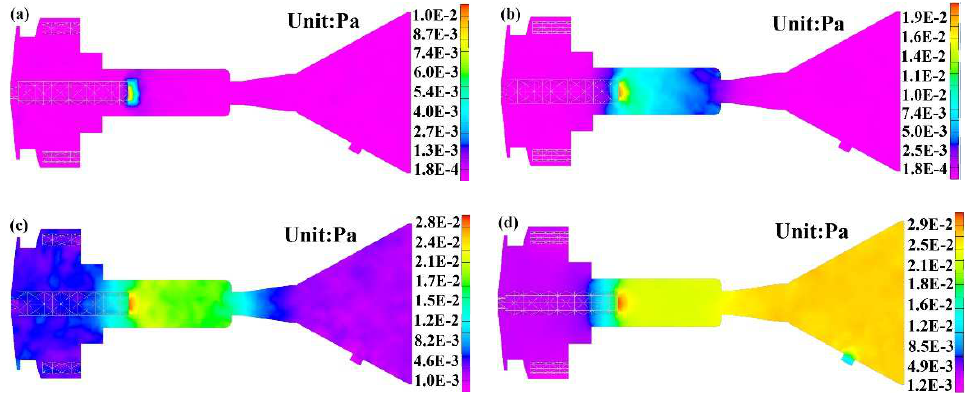
Figure 3. Pressure distribution of the gas particles at: ( a ) 100 ns, ( b ) 1 ms, ( c ) 20 ms, and ( d ) 100 ms.